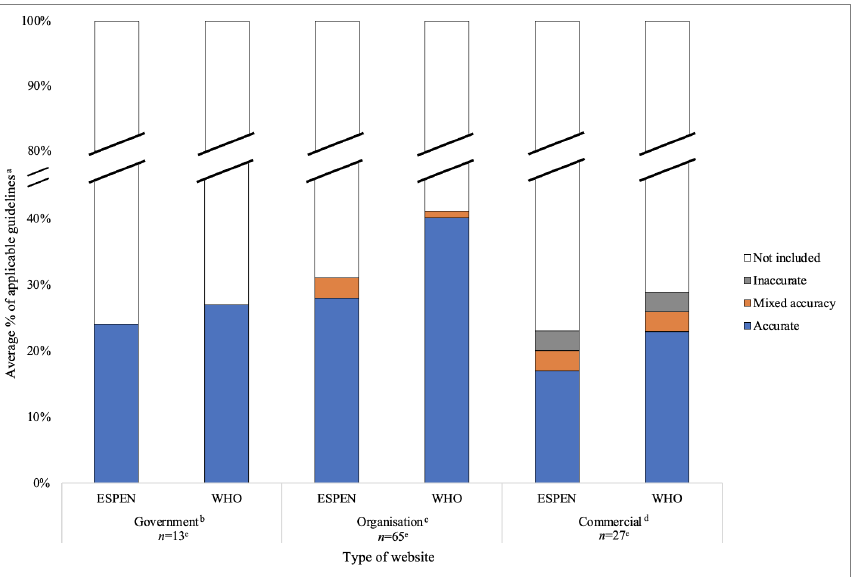
Figure 1. Accuracy of information (%) in accordance with the European Society for Clinical Nutri- tion and Metabolism (ESPEN) and World Health Organisation (WHO) guidelines, by website type.